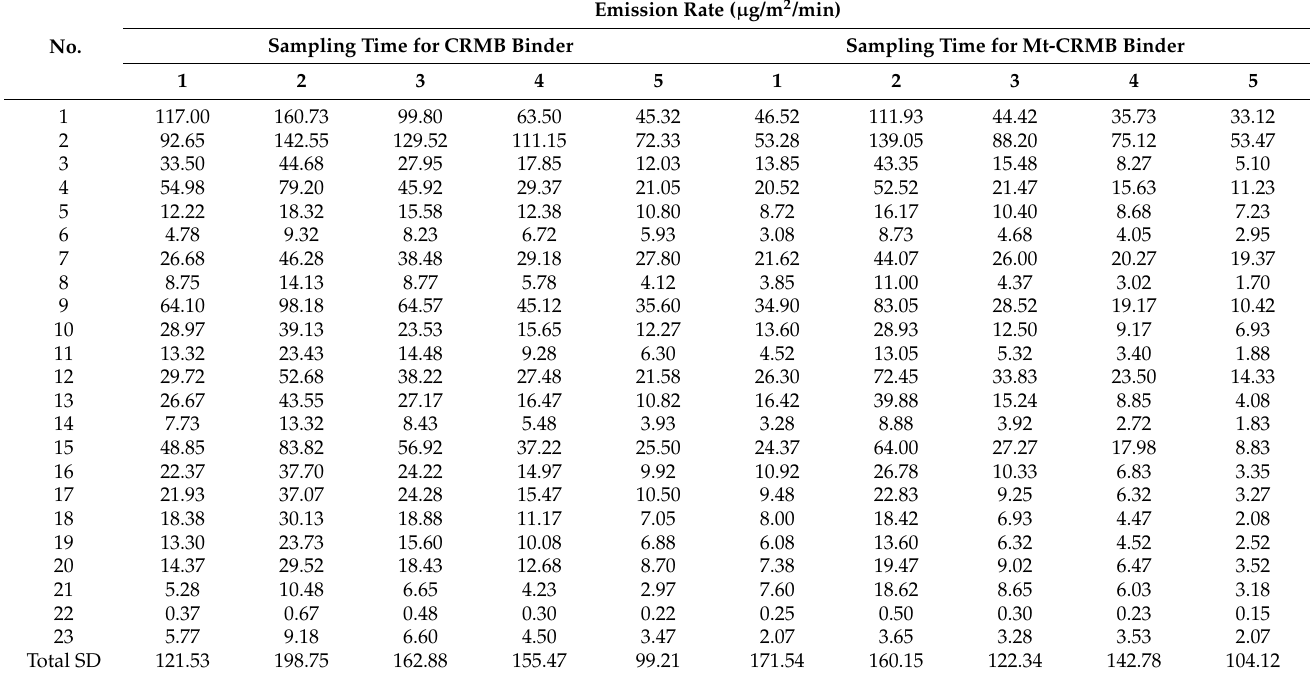
Table 4. Emission rate, V ( t ) , of 23 fingerprint compounds for CRMB and Mt-CRMB binders at different times.